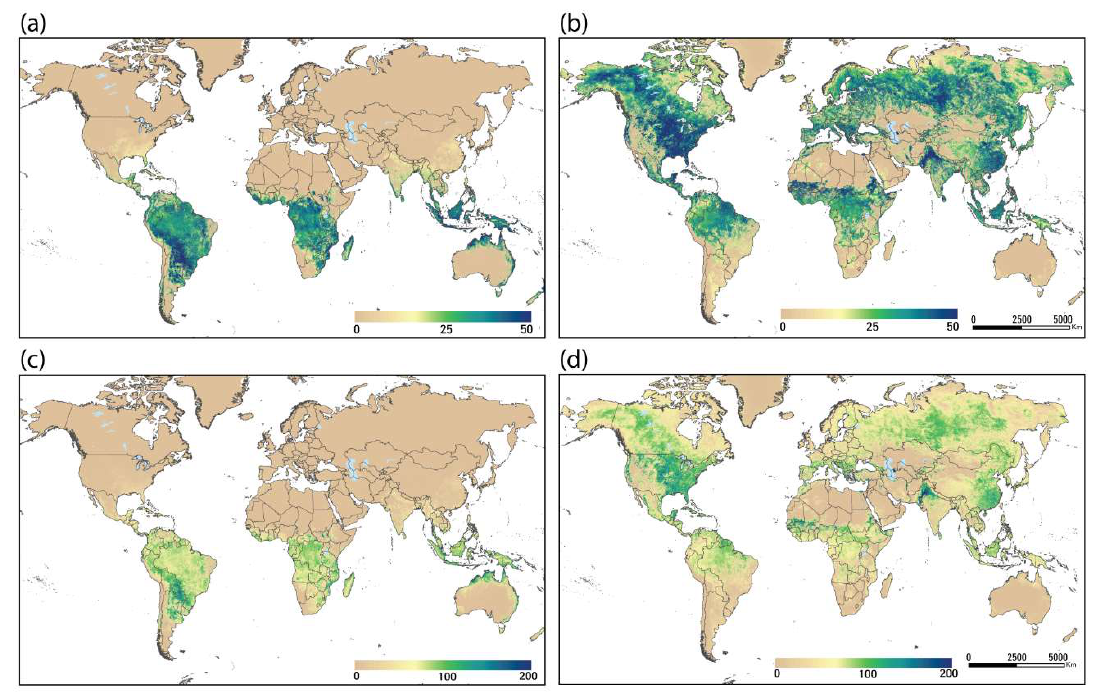
Figure 2. ( a ) Actual ET (mm) for dekad 1, January 2018 (1.1.2018–10.1.2018), ( b ) actual ET (mm) for